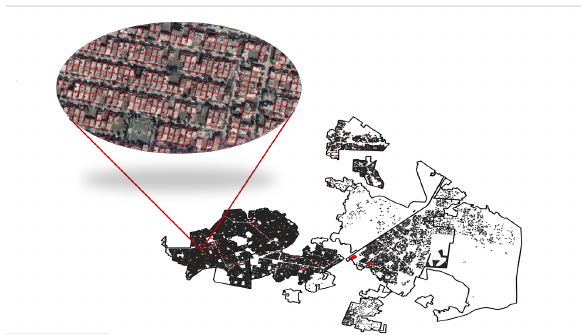
Figure 2. Details of the marked Area. The complete marked area of Defence Housing Authority (DHA), Lahore, along with a zoomed in look at the marked footprints